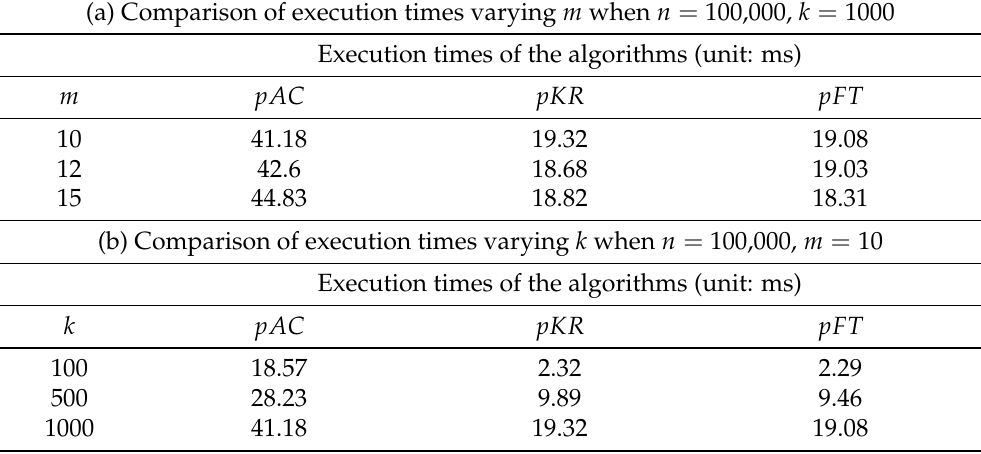
Table 4. Comparison of execution times of pAC , pKR , and pFT for ECG data. (a) Comparison of execution times varying m when n = 100,000, k = 1000 Execution times of the algorithms (unit: ms)